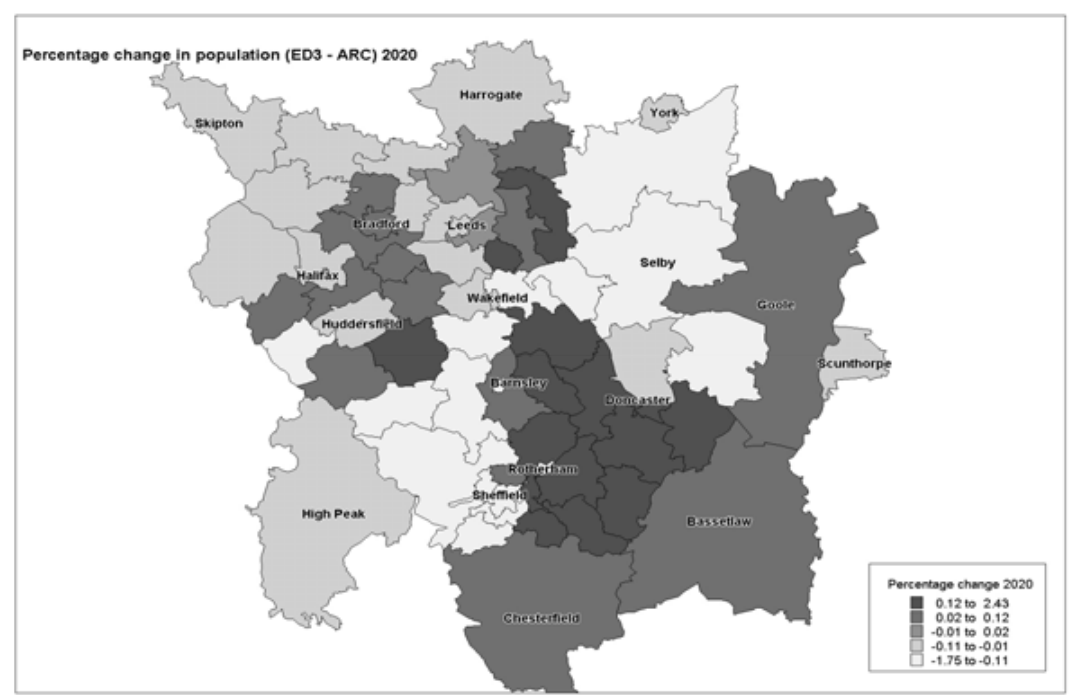
Figure 4. ED3 test: impacts on population,